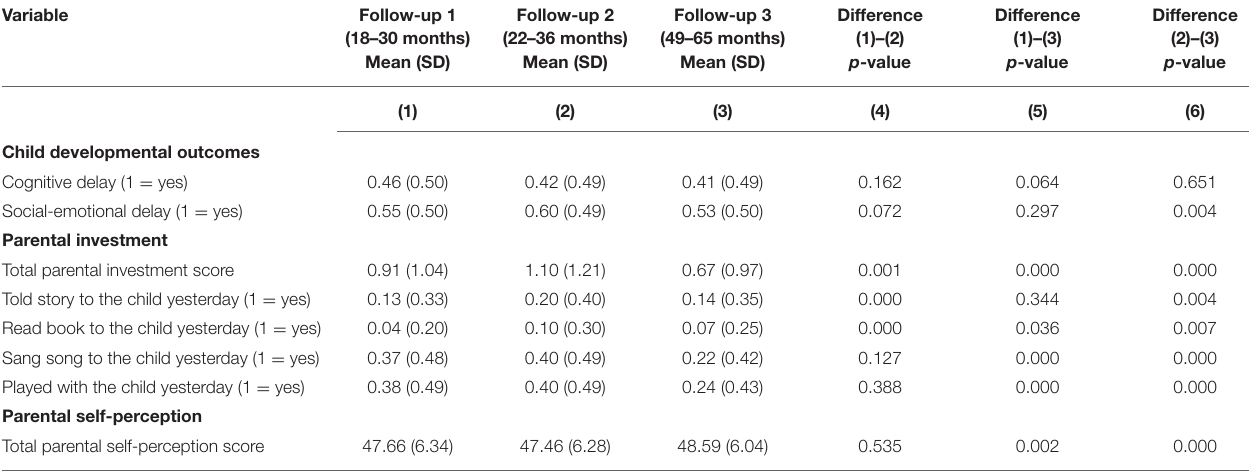
TABLE 2 | Child developmental outcomes, parental investment, and parental self-perception ( N =